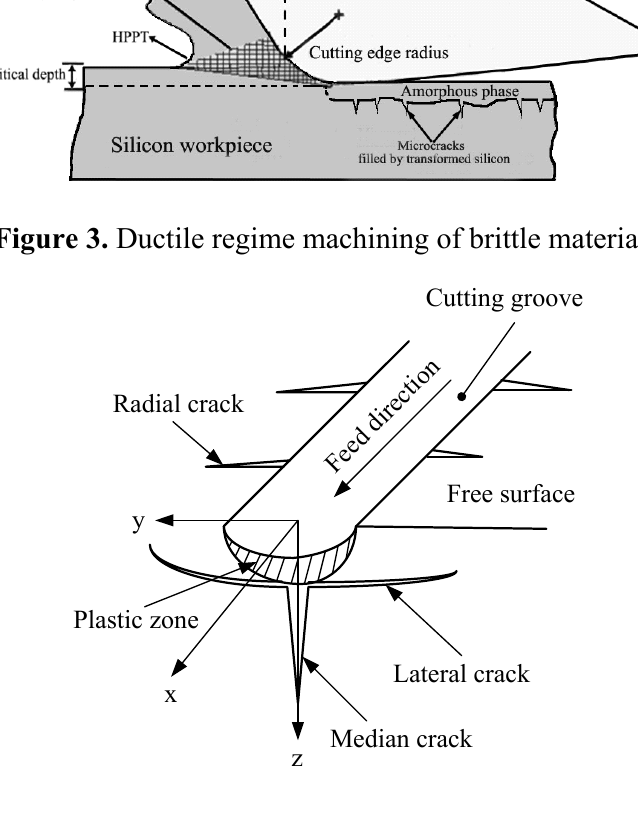
Figure 4. Schematic of cracking induced by plunge-cutting of brittle